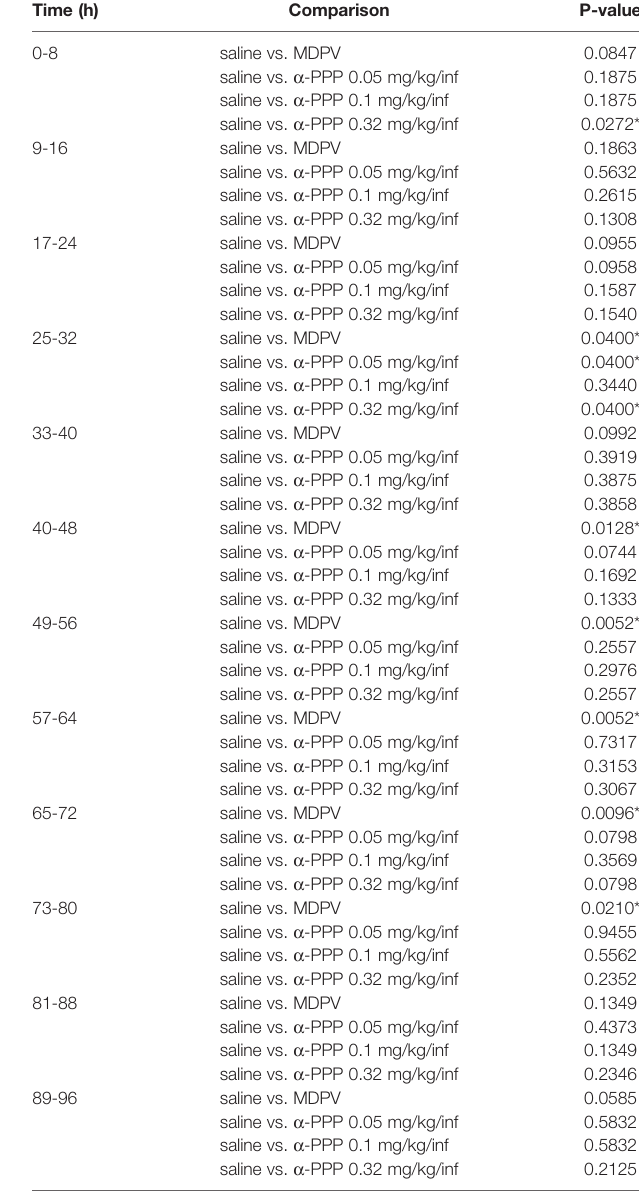
Asterisks indicate statistically signi fi cant differences vs.